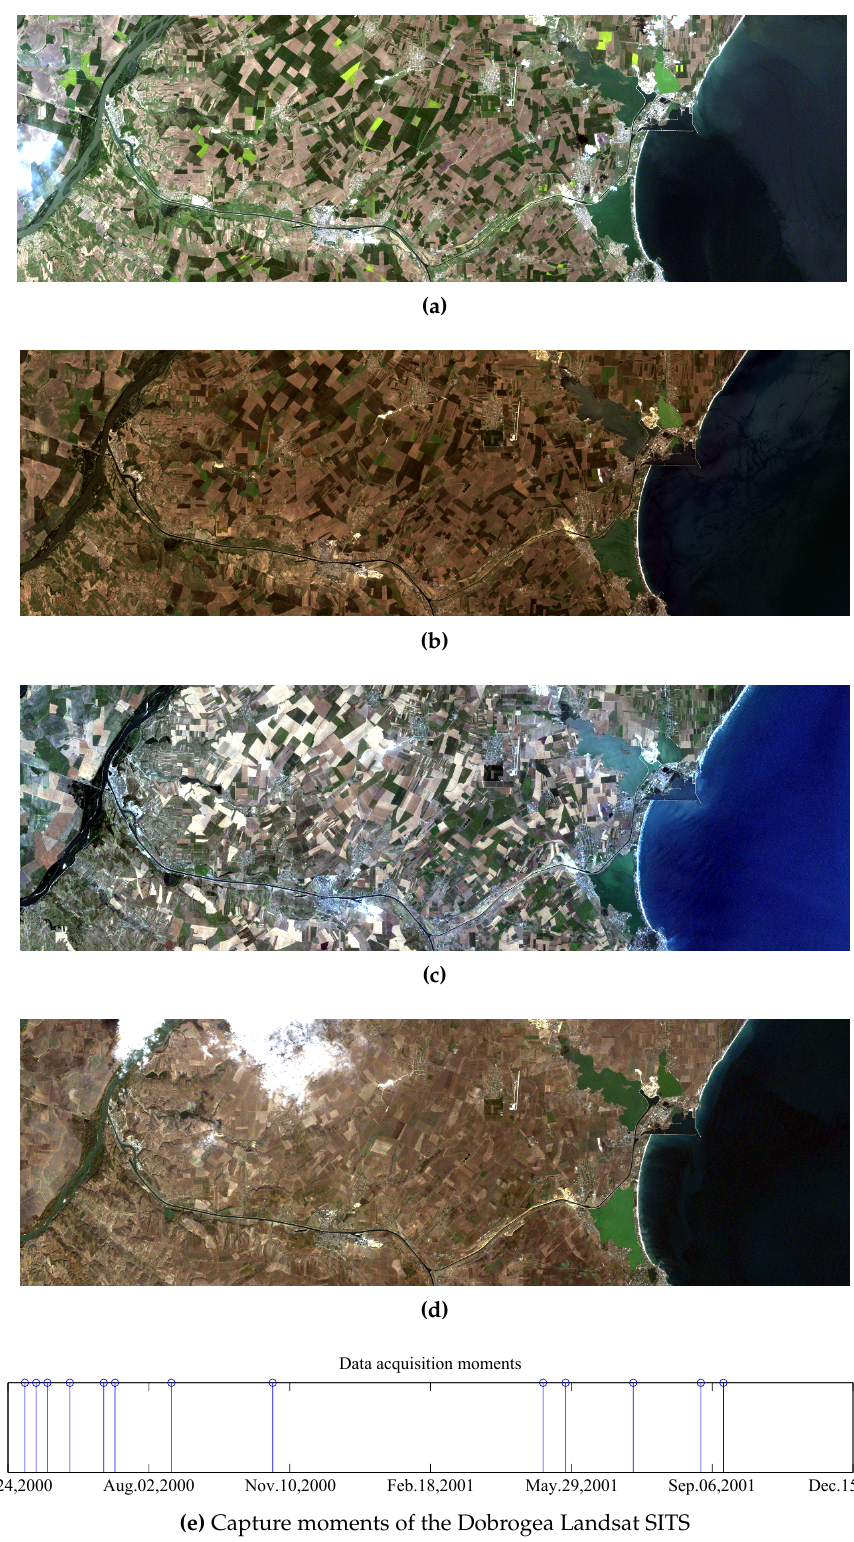
Figure 5. Dobrogea Landsat SITS comprised of 13 images captured between 6 May 2000 and 14 September 2001, in the Dobrogea region. Four images of the series are shown, namely: ( a ) 6 May 2000, ( b ) 22 May 2000, ( c ) 9 July 2000, and ( d ) 29 October 2000. The distribution of the acquisition moments is shown in ( e